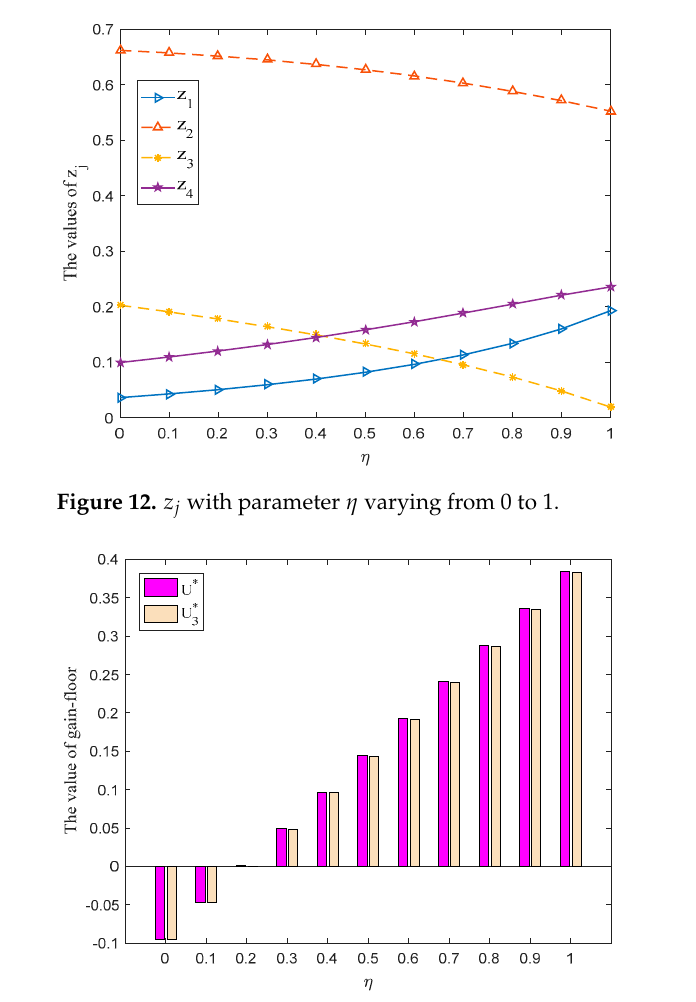
Figure 13. The gain-floor U ∗ and